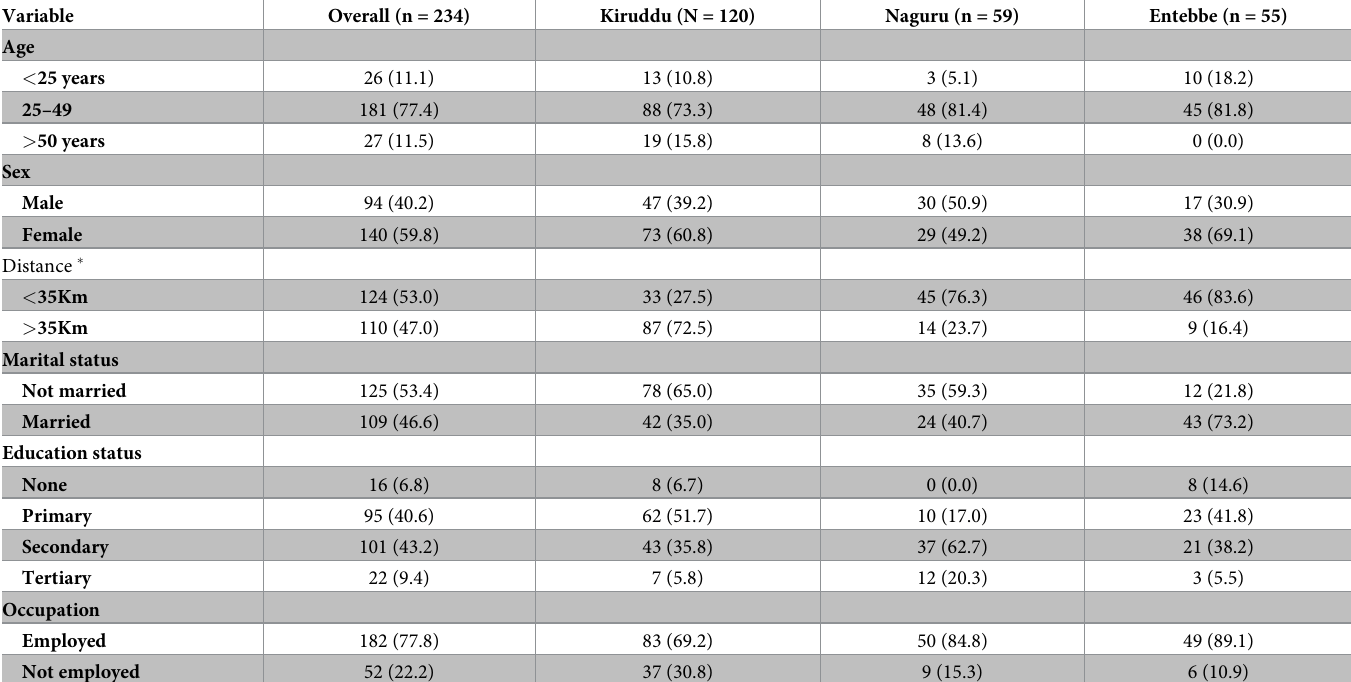
Table 1. Baseline demographic characteristics of hospitalized patients with a recent HIV diagnosis stratified by study site.